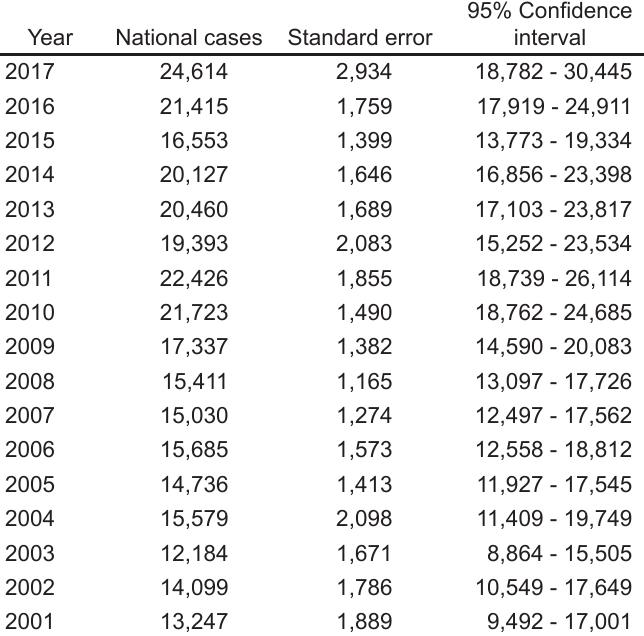
Table 1. Weighted national estimates of pediatric patients presenting to United States emergency departments with subluxations of the radial head,